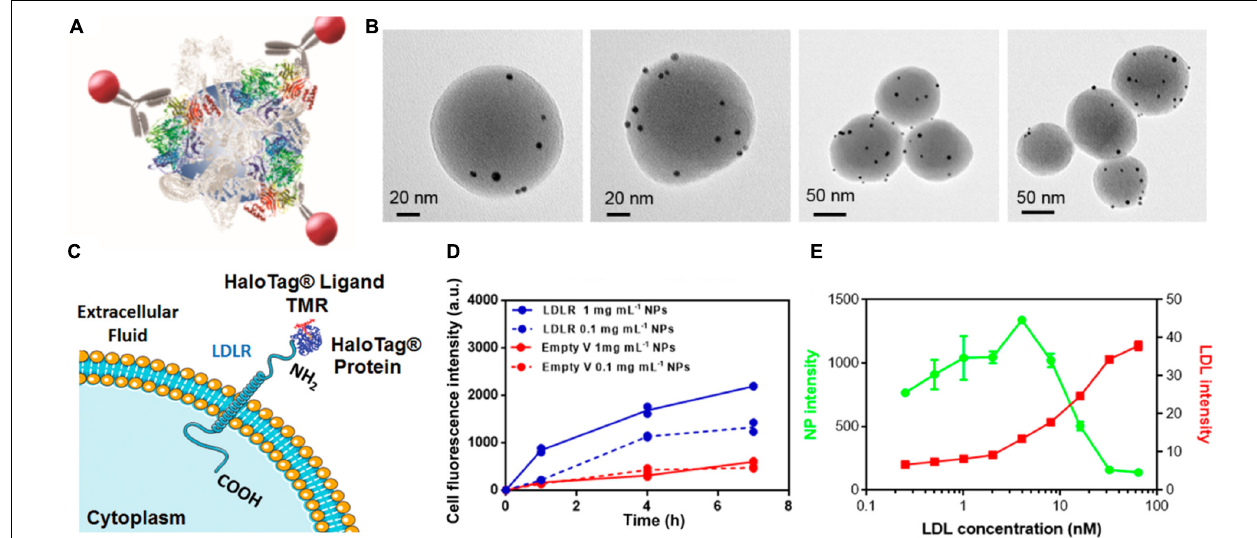
FIGURE 4 | Mapping of receptor binding motifs on the biomolecular corona and identification of receptors mediating uptake by cells. Schematic illustration of epitope mapping of ApoB-100 on the biomolecular corona of SiO 2 nanoparticles by 5 nm immunogold nanoparticles conjugated with antibody anti-ApoB100 (A) . Electron micrographs of ApoB-100 epitopes on the hard corona of SiO 2 nanoparticles formed in 50% human serum and subsequently exposed to 50% delipidized serum for 4 h (B) . Scheme of the low-density lipoprotein receptor LDLR fused with a fluorescently labeled HaloTag protein at its N-terminus (C) . Uptake of nanoparticle-corona complexes in 50% delipidized serum in LDLR-transfected cells and control cells (Empty) (D) . Uptake of nanoparticles-corona complexes can be competed with LDL in LDLR-transfected cells (E) . All panels in this Figure are adapted with permission from Lara et al. (2017)–Copyright (2017) American Chemical